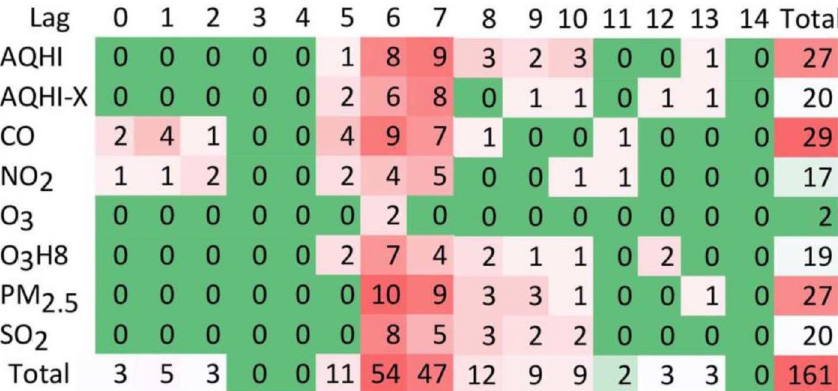
Fig 2. Total frequencies for all associations: Five air pollutants + two air quality health indices (rows) and 15 time lags of 0–14 days (columns), between exposure to urban air pollutants levels and the number of ED visits for episodic and paroxysmal disorders (G40-G47) in Toronto, Canada between April 1, 2004 and December 31, 2015. For visual representation: 0 (green) colour represents others than positive statistically significant associations. https://doi.org/10.1371/journal.pone.0270459.g002 Exposure to other pollutants, such as PM and SO may also contribute to central nervous 2.5 2 system disorders. Exposure to both pollutants may result in higher prevalence of multiple scle- rosis [55, 56] and higher risk of progression of PD [54] and AD [4]. In a Canadian study, expo- sure to ambient SO and PM was associated with increased risks of ED visits for depression 2 2.5